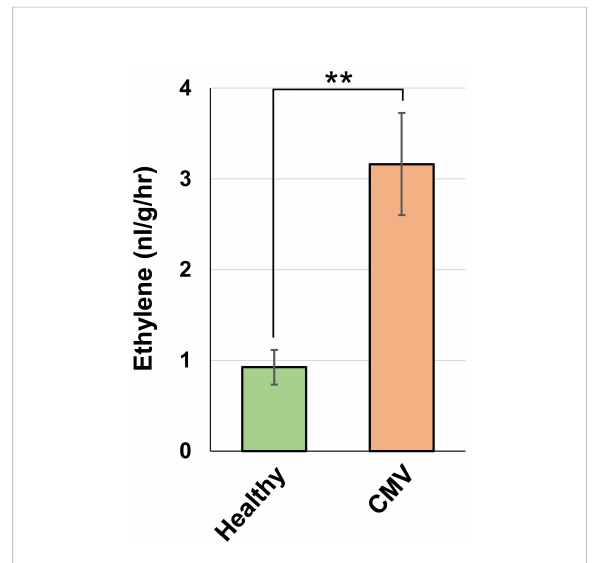
FIGURE 6 Effect of CMV infection on ethylene emission in pepper. Ethylene emission by upper uninoculated leaves of healthy and CMV- infected plants, as measured using gas chromatography. The mean ± SD values from three independent experiments are shown, and each column represents one group with nine plants. Signi fi cant differences were determined using paired Student ’ s t - test (** P <